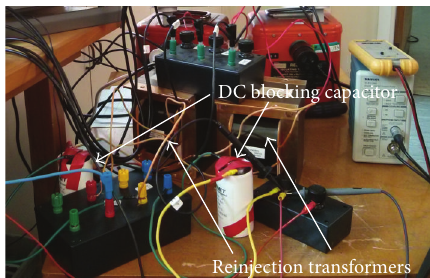
Figure 22: Three-level MLCR CSC prototype and associated auxiliaries: the DC side reinjection transformer.